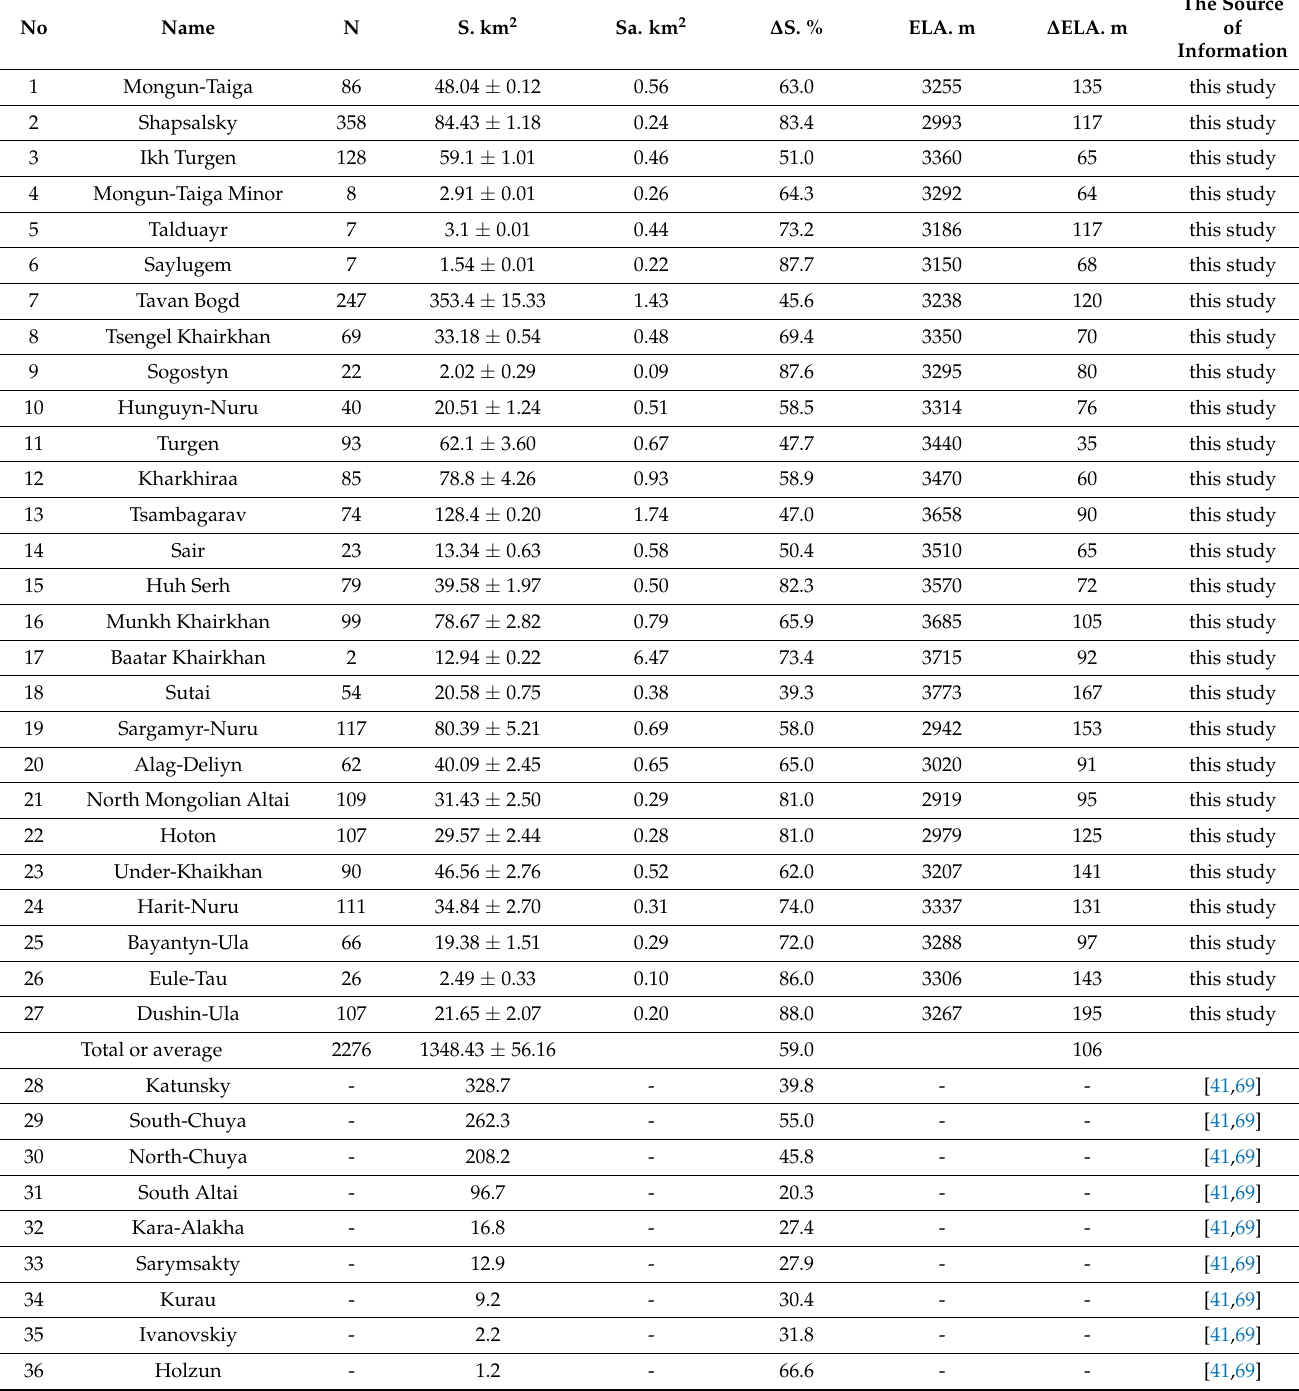
Table 5. Glaciers of Altai in the maximum of the LIA and subsequent glacial recession. Abbreviations in the header are shown in Table